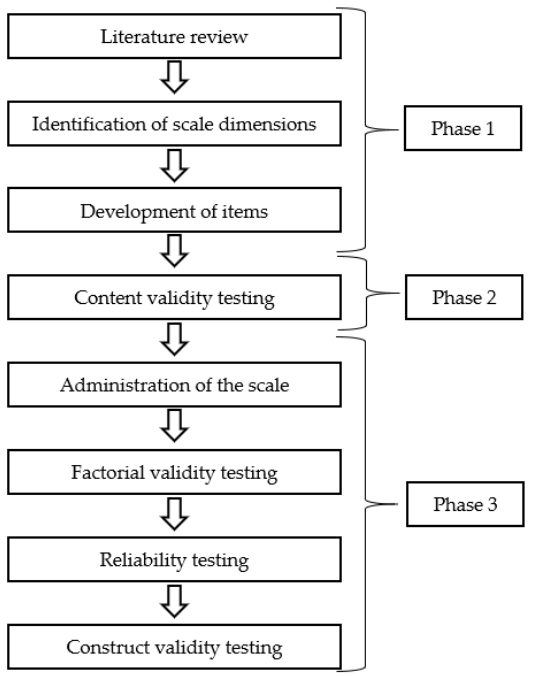
Figure 1. Workflow of the development of the Self-Care in COVID-19 (SCOVID) scale.